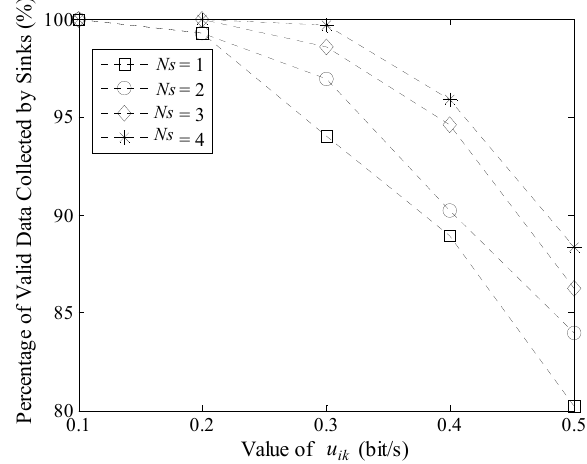
Figure 28. Percentage of valid data collected by Sinks (100 m × 100 m, 200 nodes).